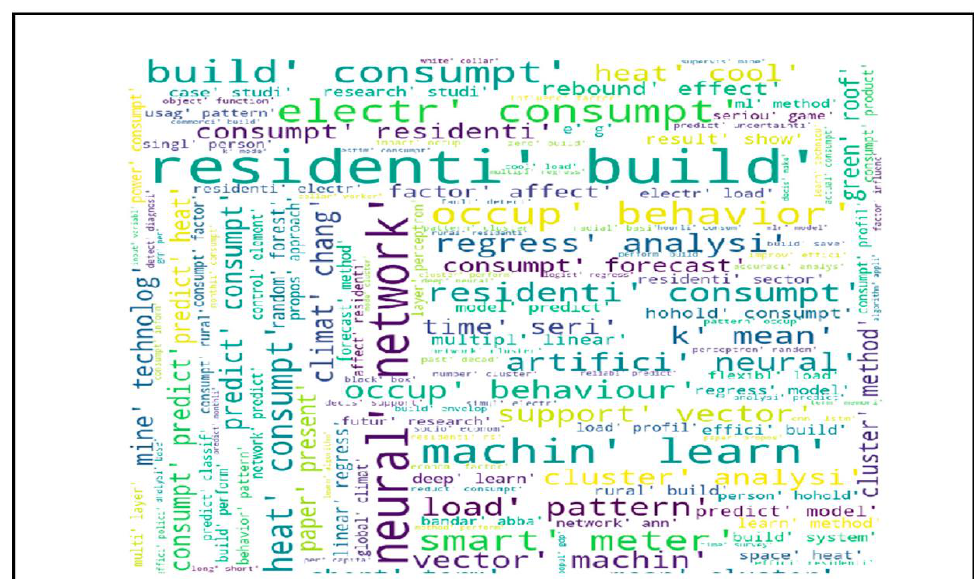
Figure 4. Word cloud for intelligent techniques applied to energy.